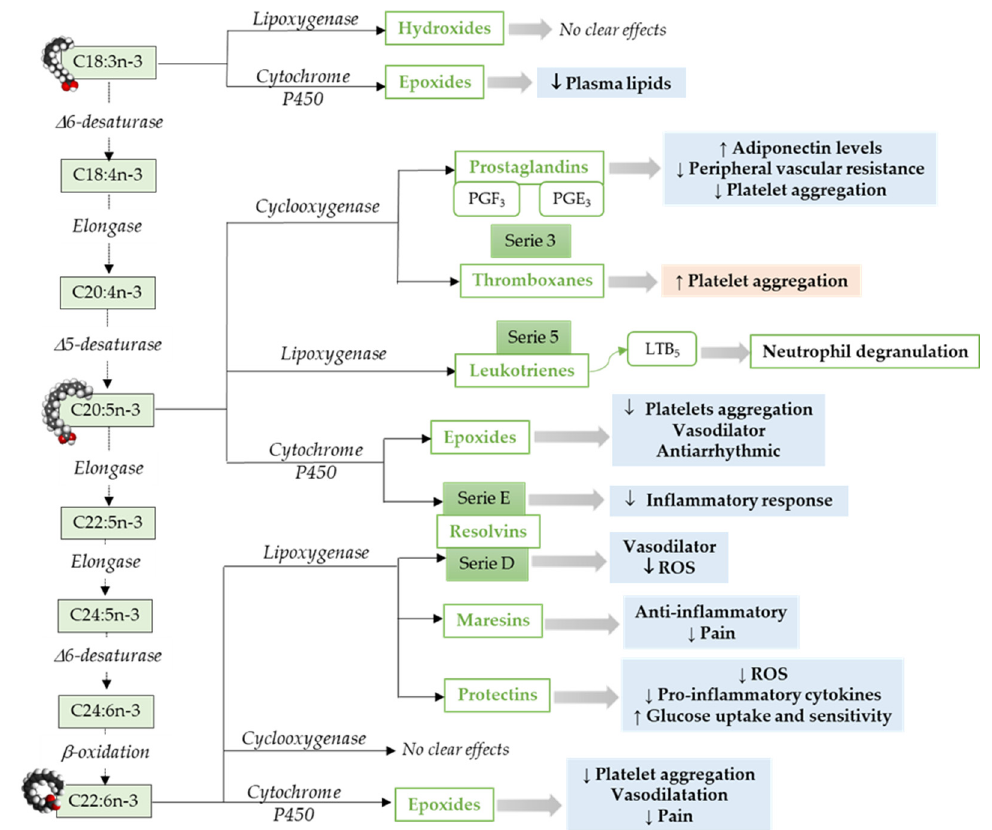
Figure 2. Pathways to synthesize n-3 LCPUFA-derived lipid mediators and its function focusing on the cardiovascular system and vascular endothelial function. C18:3n-3, α -Linolenic acid; C18:4n-3, Stearidonic acid; C20:4n-3, Eicosatetraenoic acid; C20:5n-3, Eicosapensaenoic acid; C22:5n-3, Docosapentaenoic acid; C24:5n-3, Tetracosapentaenoic acid; C24:6n-3, Tetracosahexaenoic acid; C22:5n-3, Docosahexaenoic acid; ROS, Reactive Oxidative Species. ↓ = Decreases; ↑ = Increases. Modified from [55] .